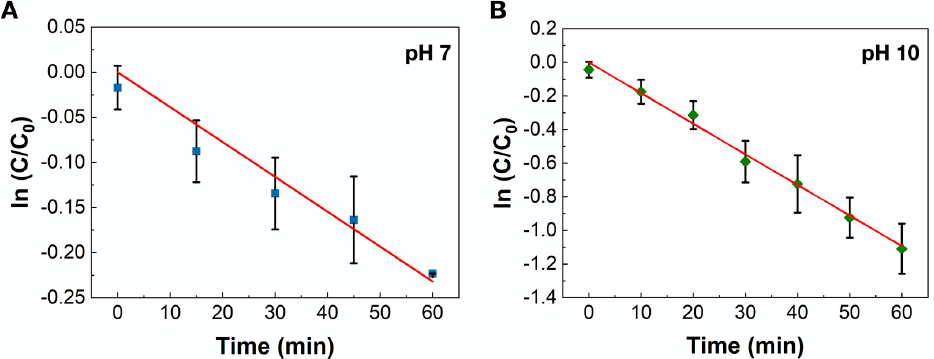
Figure 5. Pseudo-first-order reaction rate plots for H 2 O 2 decomposition at ( A ) pH 7 ( B ) pH 10. The initial concentration of H 2 O 2 is 100 mM. Pt concentration is 1.3 μ M. Reaction rates are measured at initial concentration of H 2 O 2 is 100 mM. Pt concentration is 1.3 µ M. Reaction rates are measured at 25 °C. 25 ◦